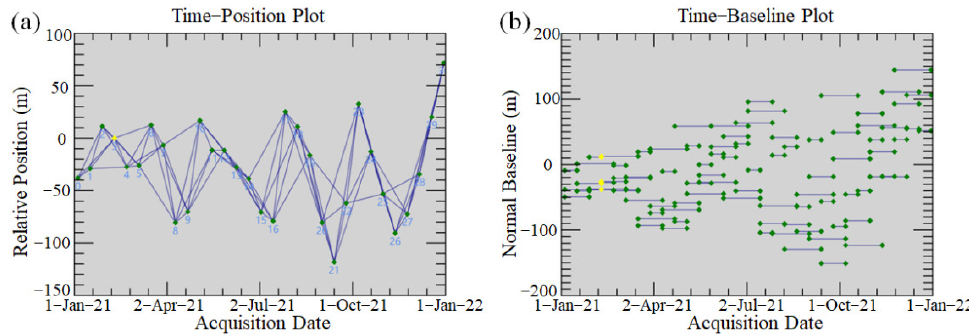
Figure 15. Spatial and temporal baselines of the SAR datasets utilized in this study. ( a ) Time-position plot of the InSAR image acquisitions. ( b ) Time-baseline plot of interference pairs of the SAR images.